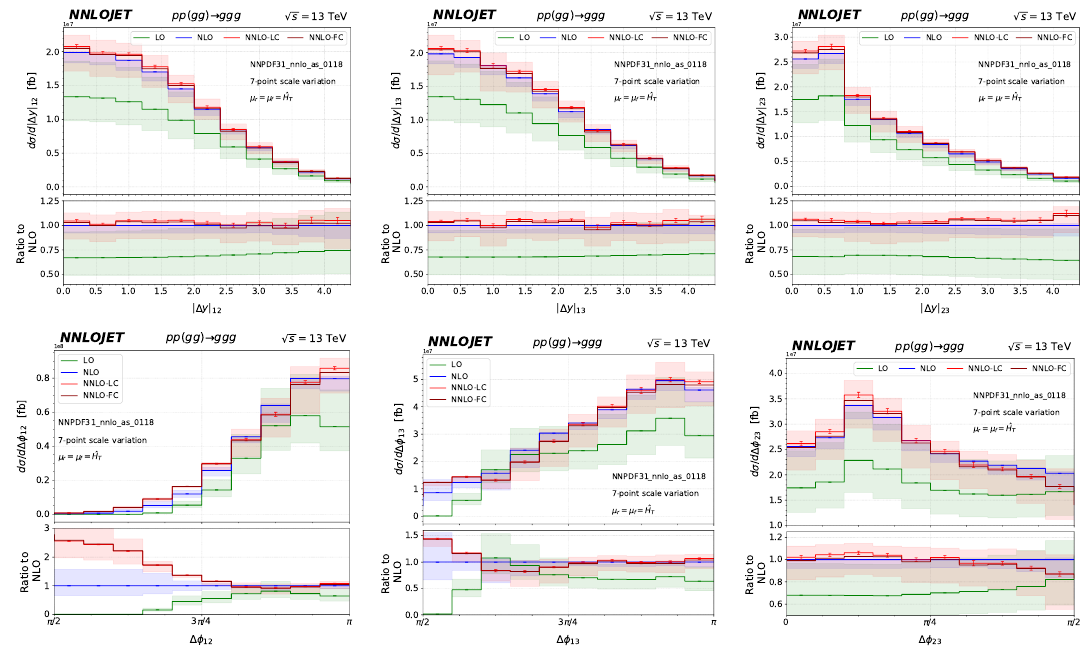
Figure 9 . Differential distributions in geometrical jet-pair variables: rapidity differences (upper row) and azimuthal angles (lower row) for gluons-only three-jet production up to NNLO. Definition of NNLO-LC and NNLO-FC as in figure